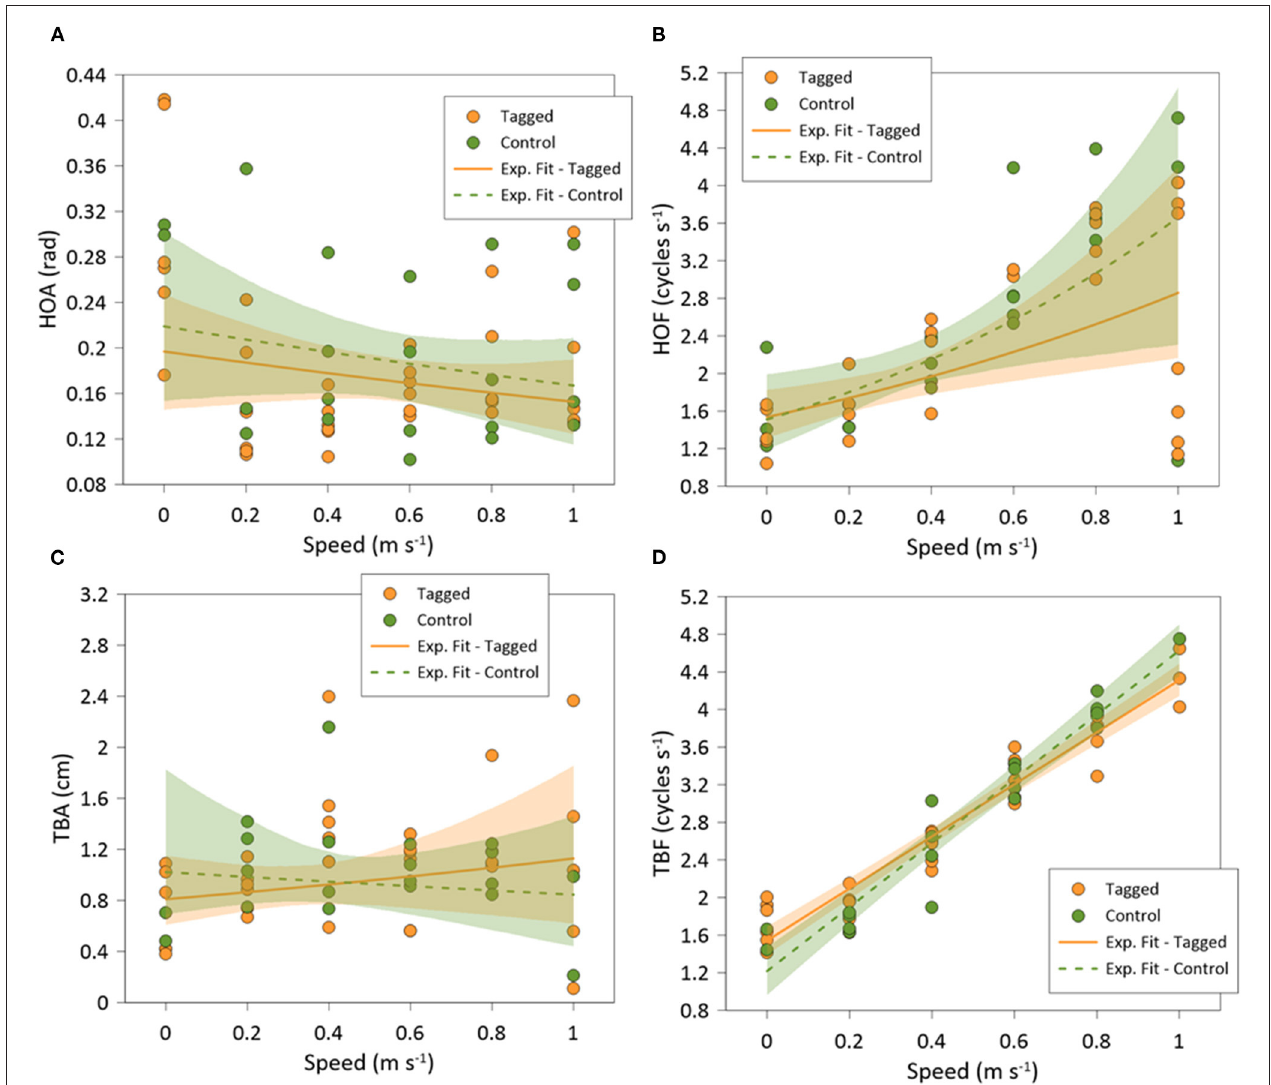
FIGURE 6 | Best-fitted regression of: (A) head orientation amplitude (HOA); (B) head orientation frequency (HOF); (C) tail beat amplitude (TBA); and (D) tail beat frequency (TBF), of tagged (orange) and control (green) Sparus aurata in swim-tunnels at different swimming speeds.